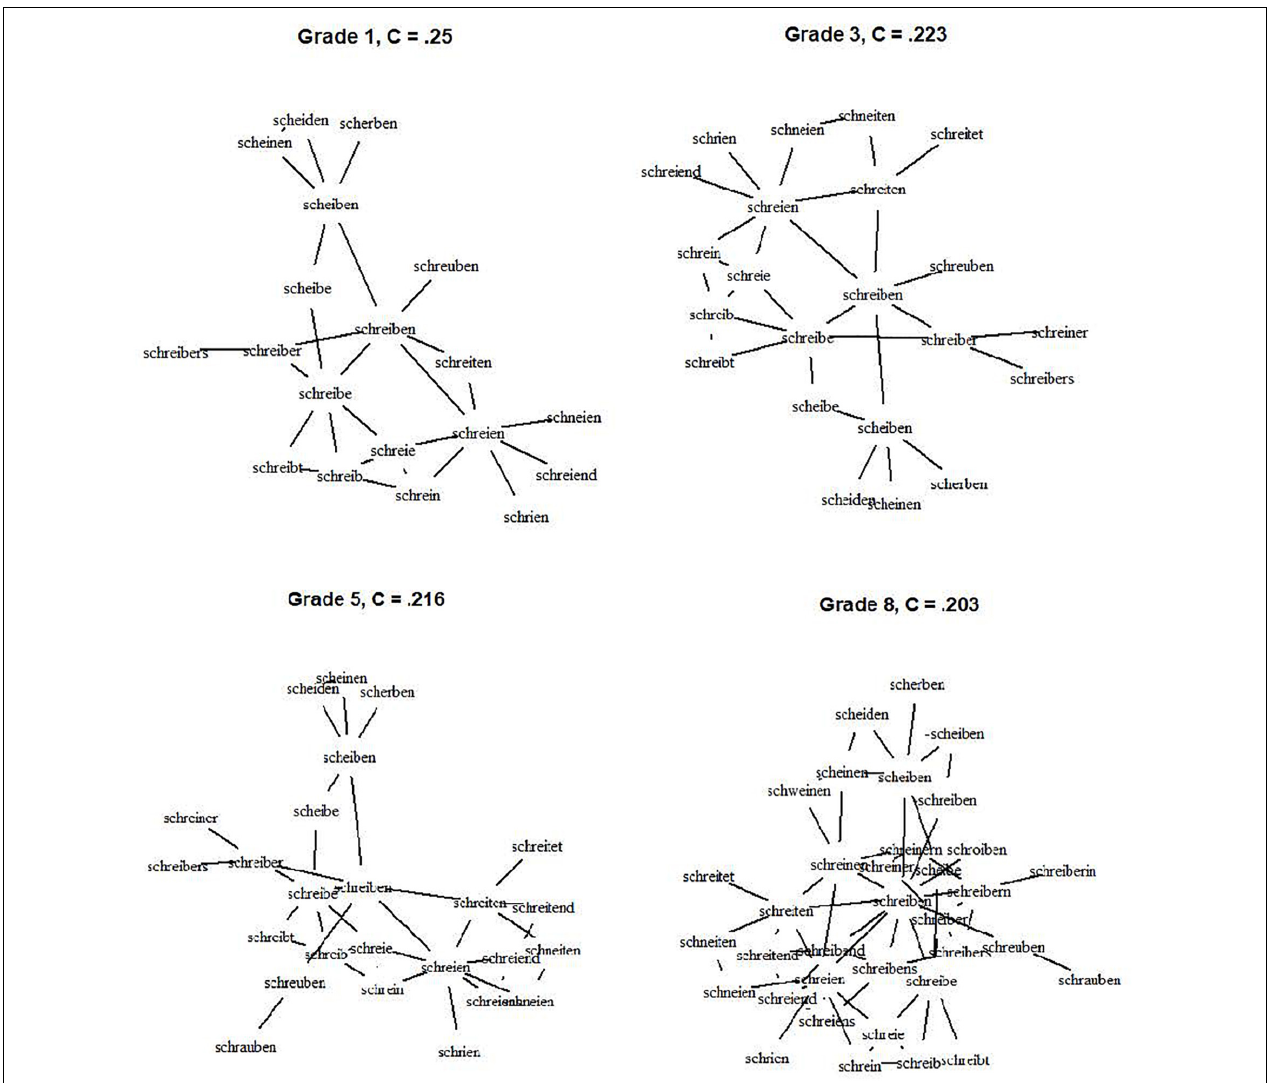
FIGURE 3 | The network and according clustering coefficient for the word “schreiben” – “to write.” Note that for reasons of comprehensibility only neighbors of a maximal Levenshtein distance of 2 are